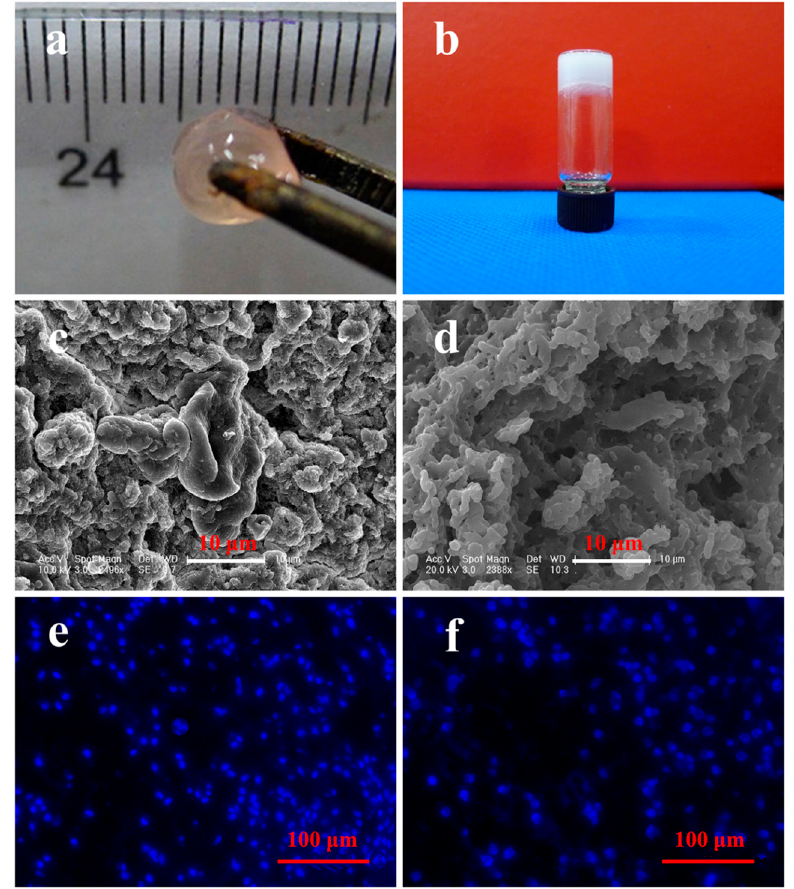
Figure 2. ( a and b ) Typical appearance and ( c and d ) SEM images of fi brin gel and PLGA − PEG − PLGA hydrogel as well as ( e and f ) DAPI staining of BMMSCs-incorporated fibrin gel and hydrogel.